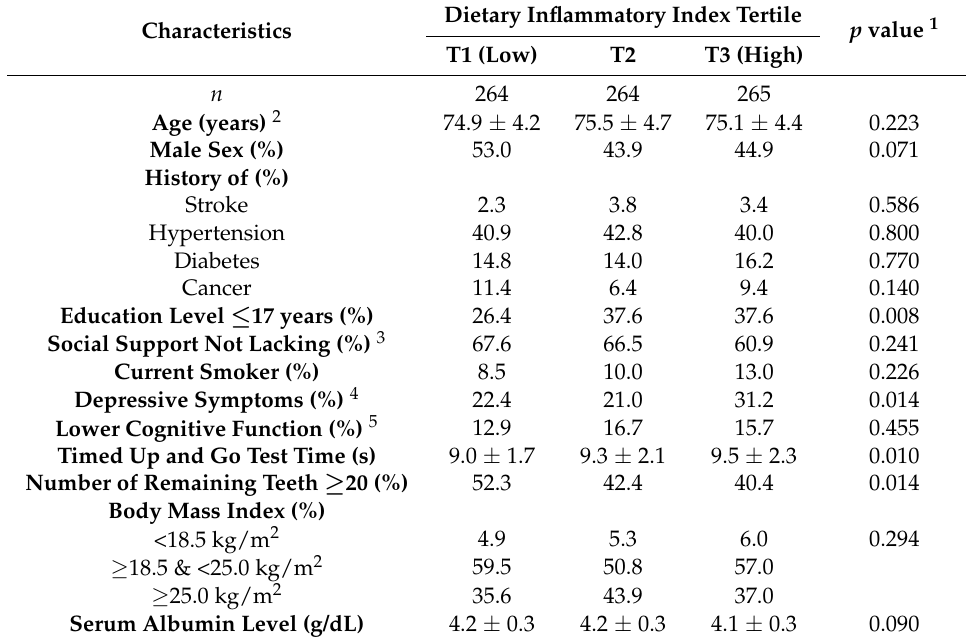
Table 1. Baseline characteristics according to dietary inflammatory index groups ( n =